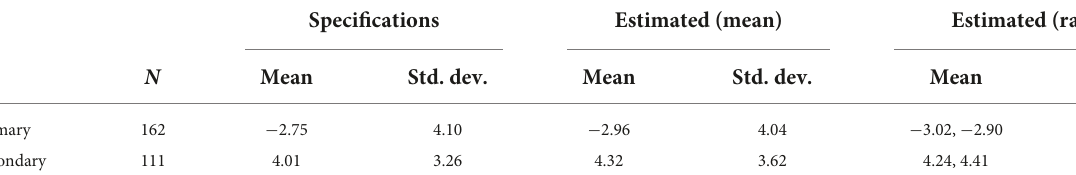
TABLE 1 Mean and standard deviation of the simulated and estimated parameters for the primary and secondary performances in the simulation study.